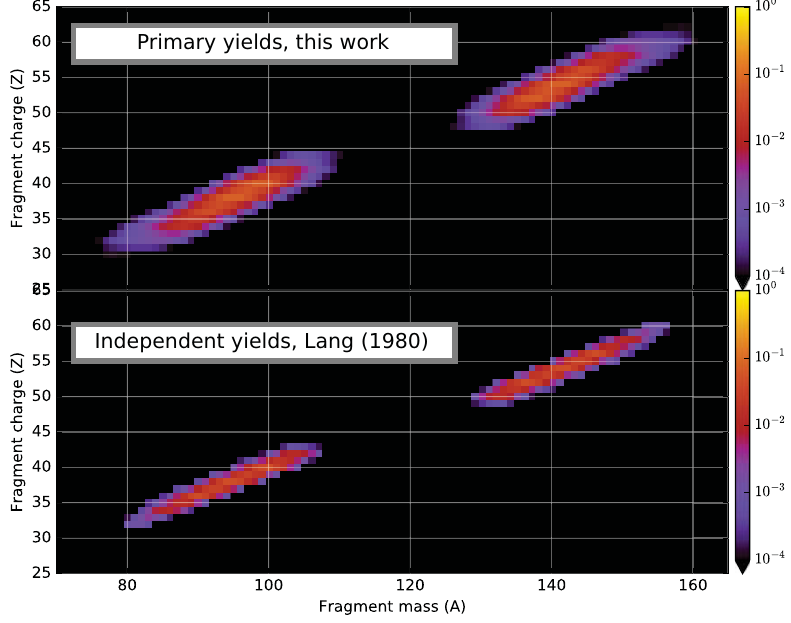
Figure 5. Same as figure 4 for the reaction 235